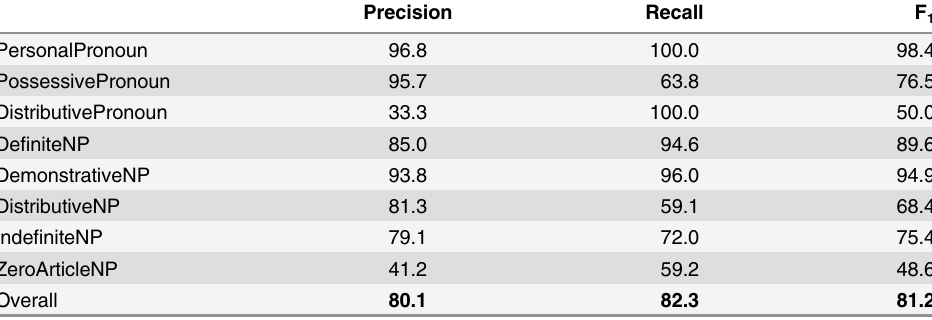
Table 8. Evaluation results for mention detection on the test portion of SPL coreference